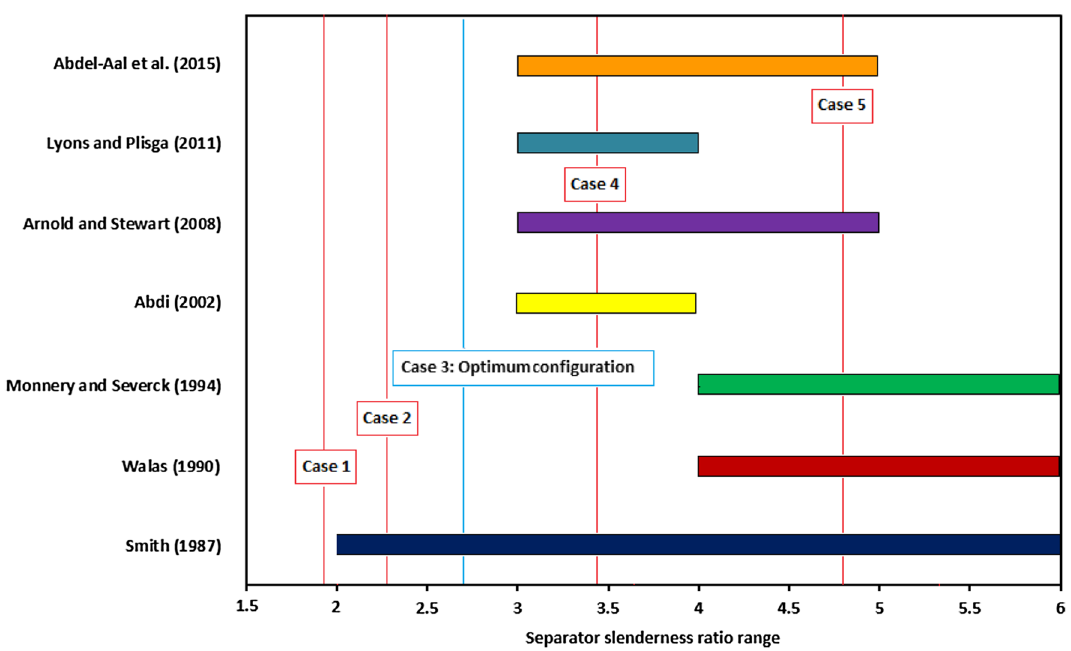
Fig. 20 Comparison of the slenderness ratio of Cases 1–5 and the slenderness ranges proposed in the